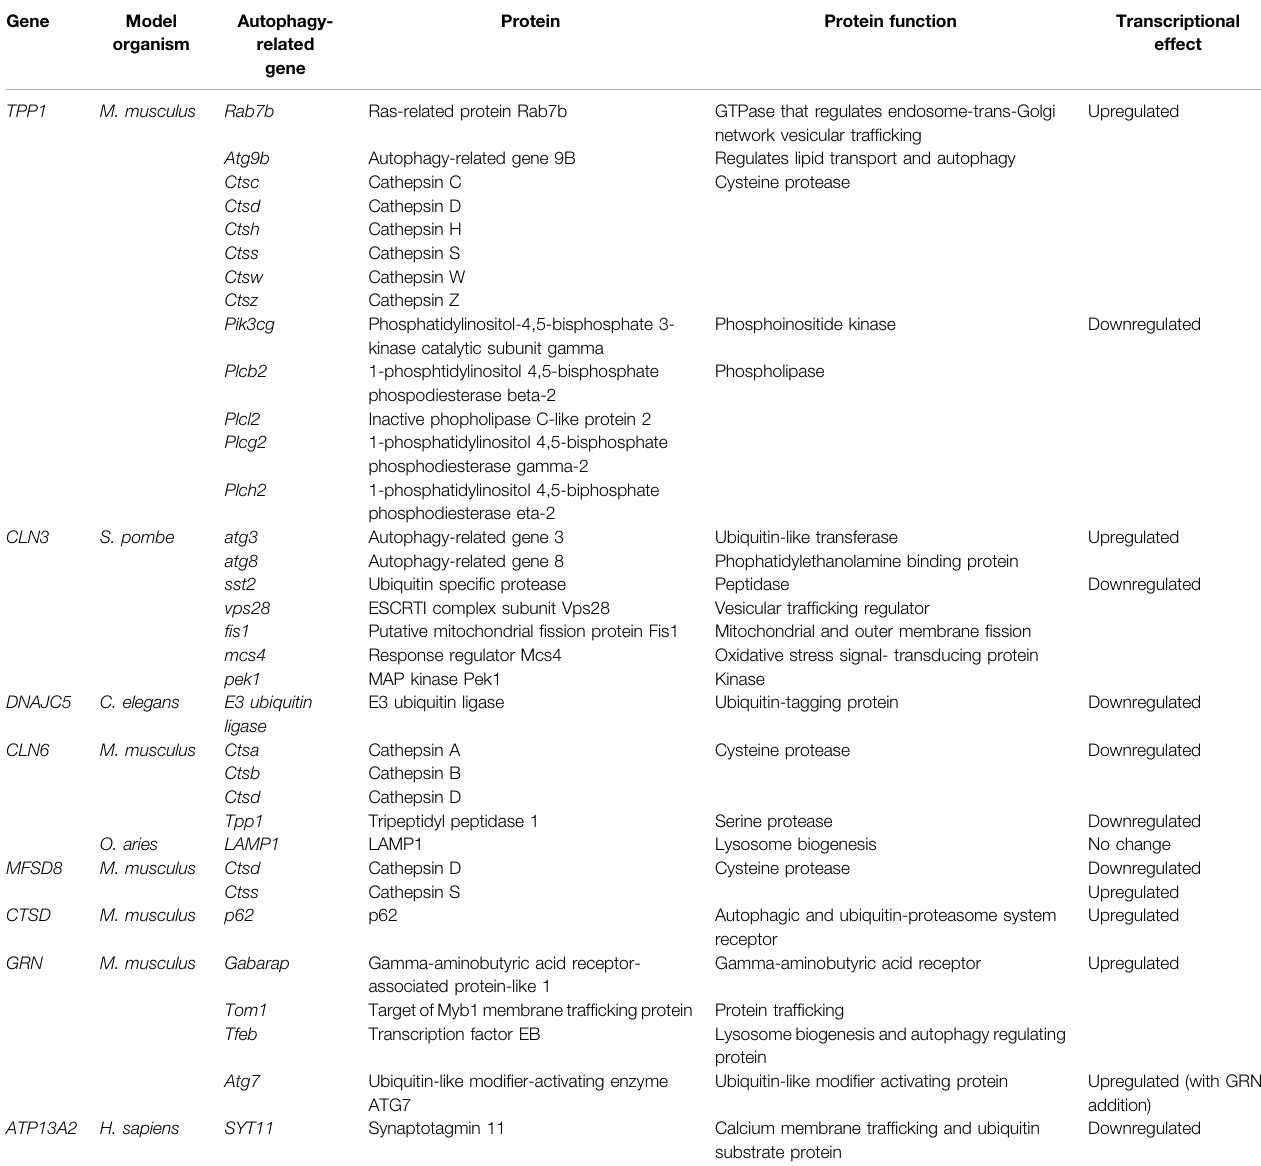
TABLE 3 | Effects of mutations in CLN genes on the expression of autophagy-related genes.